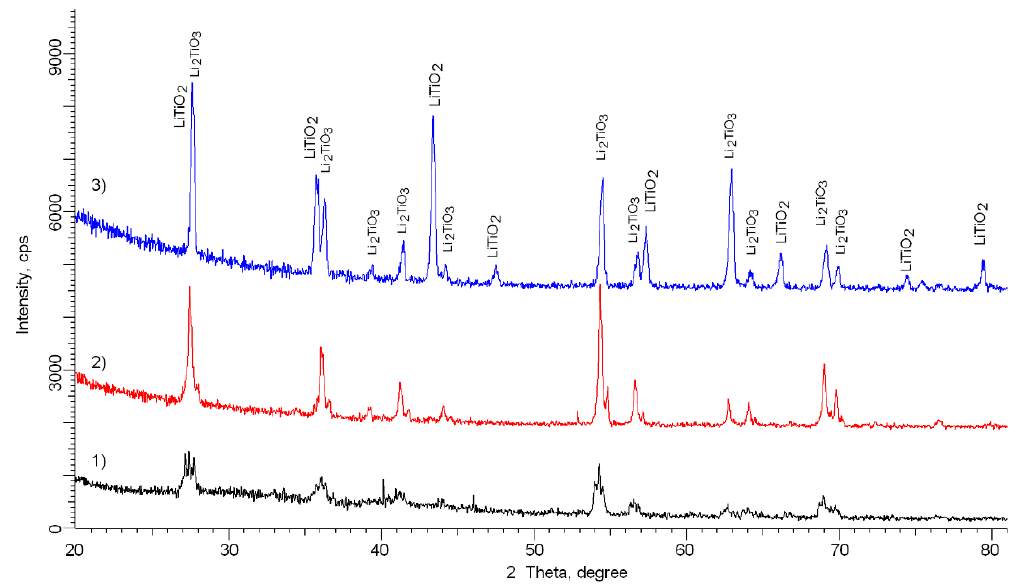
Figure 6. X-ray diffraction patterns of the test samples after corrosion tests at 75 °C: 1 ) LTO-1; 2 ) LTO-2; 3 ) LTO-3.